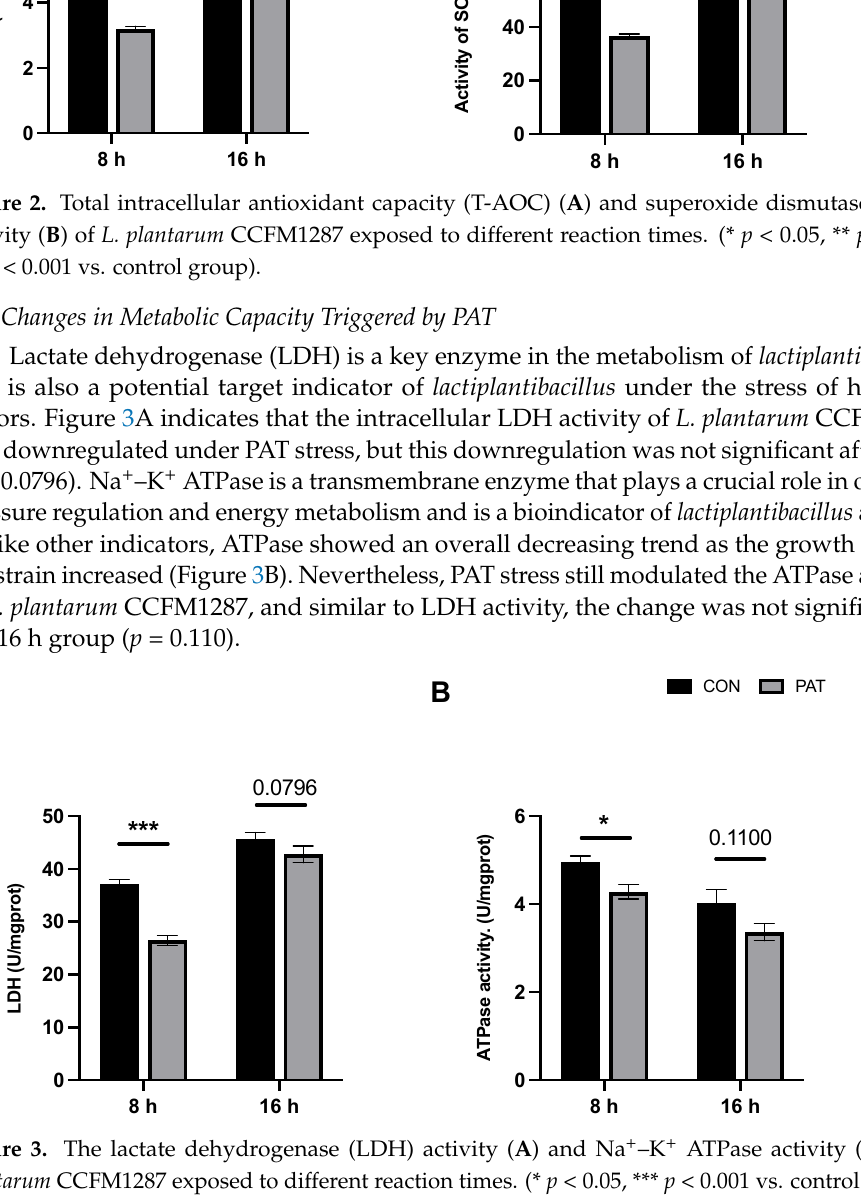
Figure 3. The lactate dehydrogenase (LDH) activity ( A ) and Na + − K + ATPase activity ( B ) of L. plantarum CCFM1287 exposed to different reaction times. (* p < 0.05, *** p < 0.001 vs. control group)